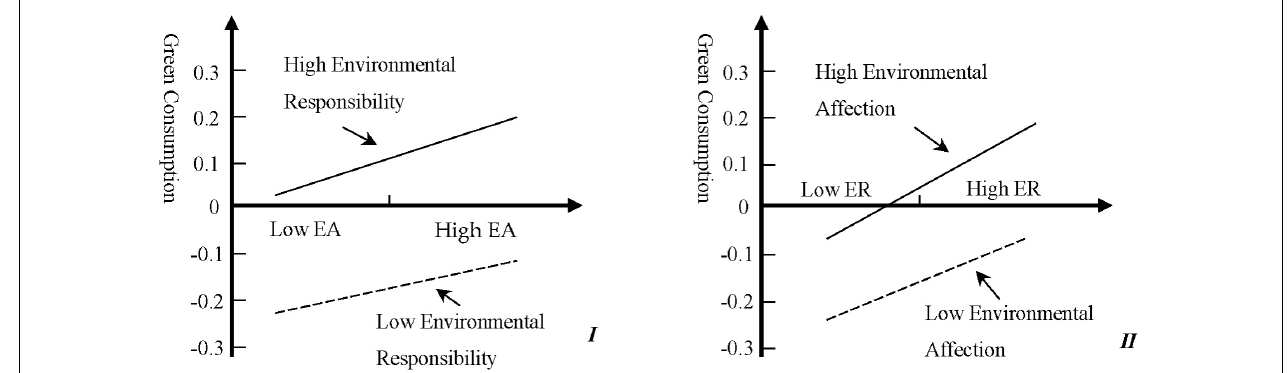
FIGURE 2 | The interaction between environmental affection and environmental responsibility.